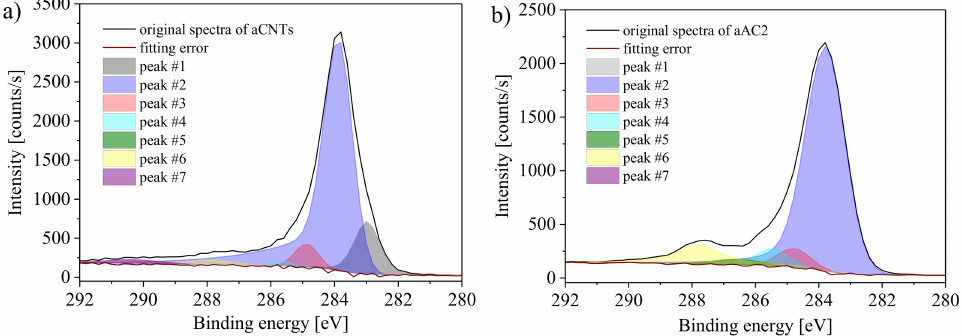
Figure 9. Examples of C1s-Peak deconvolution at ( a ) aCNTs and ( b )